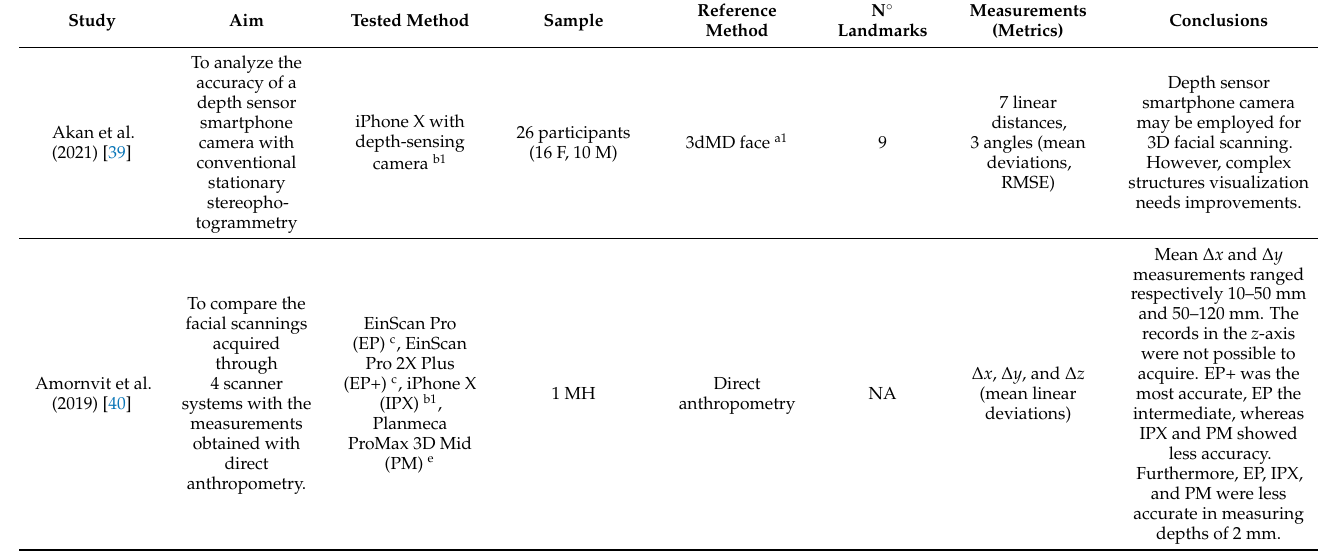
Table 3. Characteristics of the included studies. IC: impression cast, IPX: iPhone X; MH: Mannequin head; NA: not applicable; SPG: stereophotogrammetry. Stationary Stereophotogrammetry a1 /Portable Stereophotogrammetry a2 ; Smartphone structured light scanner b1 /photogrammetry b2 ; Tablet con- nected to a portable dual-structured light scanner b3 ; Laser scanner c ; Structured light scanner d